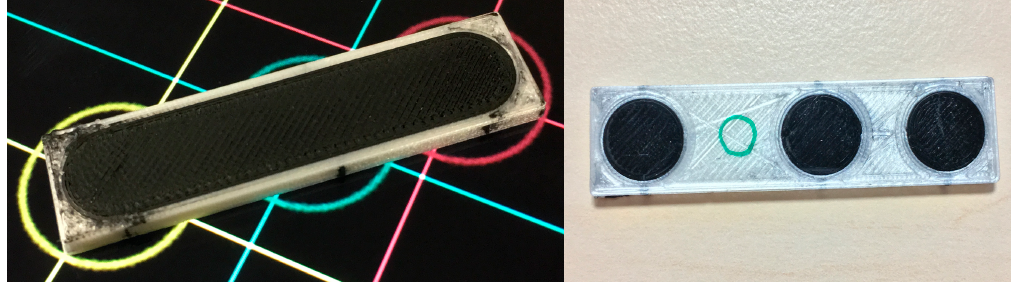
Figure 4. Left: Real 3D printed marker being detected untouched on capacitive touch screen, visualized by colored circles and hair crosses on the display. The black material is conductive PLA (polylactide), the white one is insulating PLA. Right : Bottom view of this capacitive marker (with no insulating layer as the pads rest directly on the touch screen.).